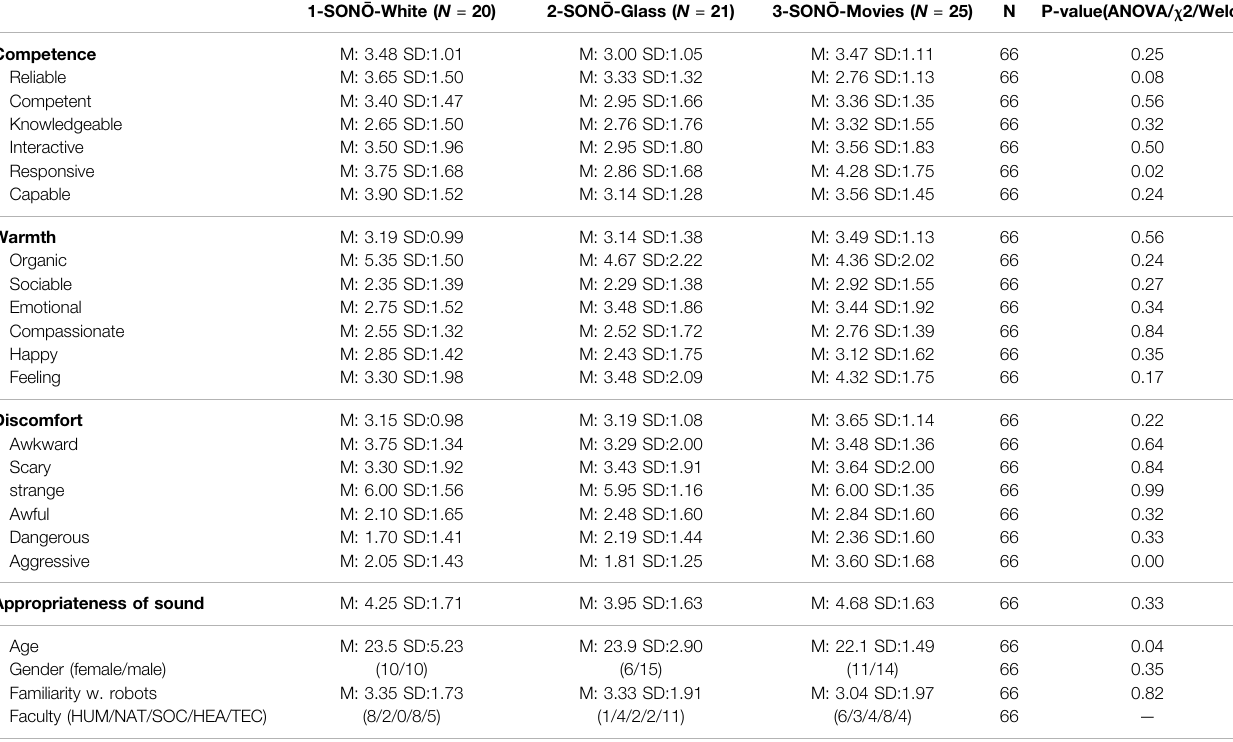
TABLE2| ResultsanddemographicdatafromExperiment1.Groupsunder “ Faculty ” indicateunderwhichfacultytheparticipantstudiesifastudentattheuniversity(HUM (cid:1) humanities, NAT (cid:1) natural sciences, SOC (cid:1) business and social sciences, HEA (cid:1) health sciences, TEC (cid:1) technical sciences).